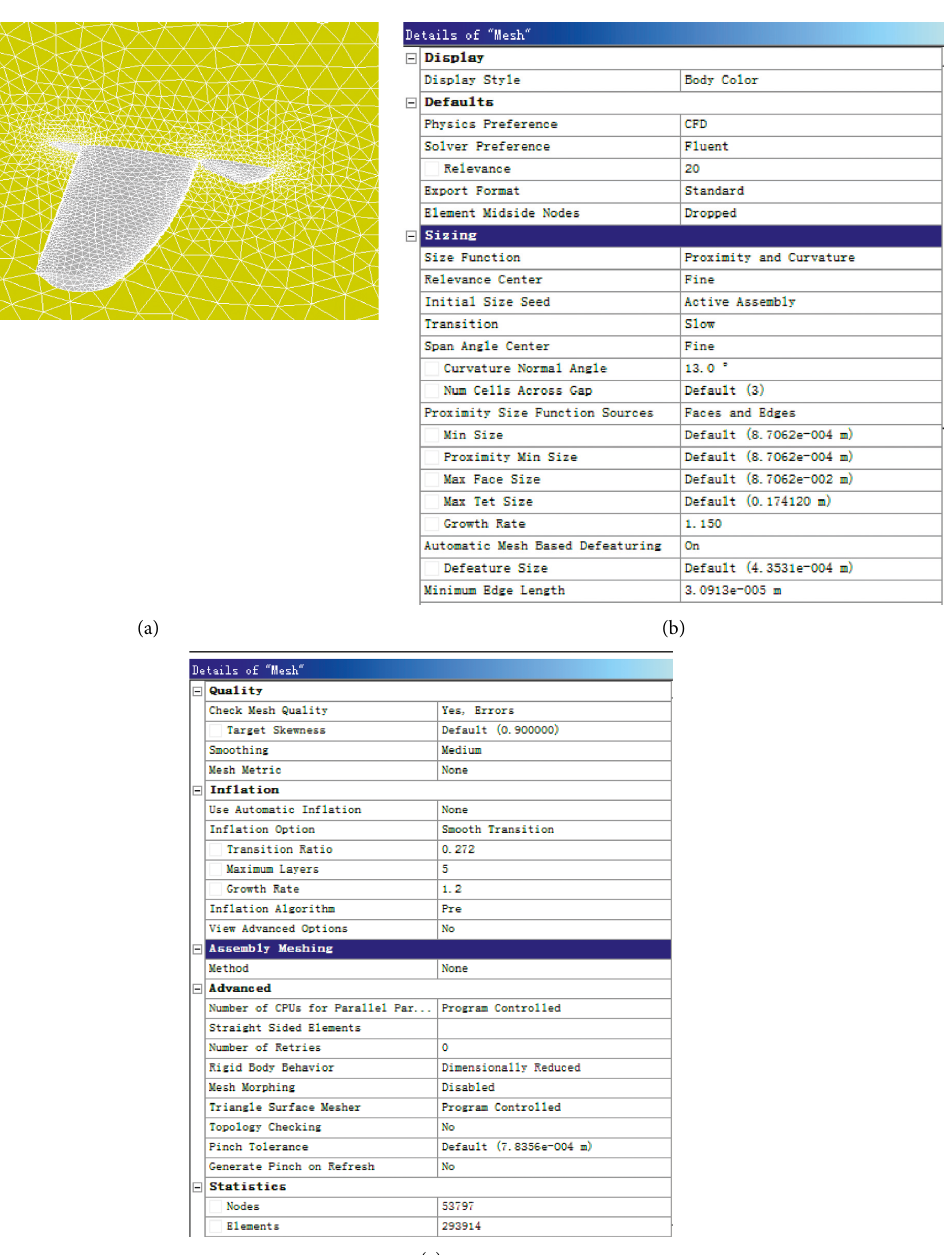
Figure 5: The meshes of both the robot and the air flow fields. (a): unstructured triangular meshes; (b) and (c): details of